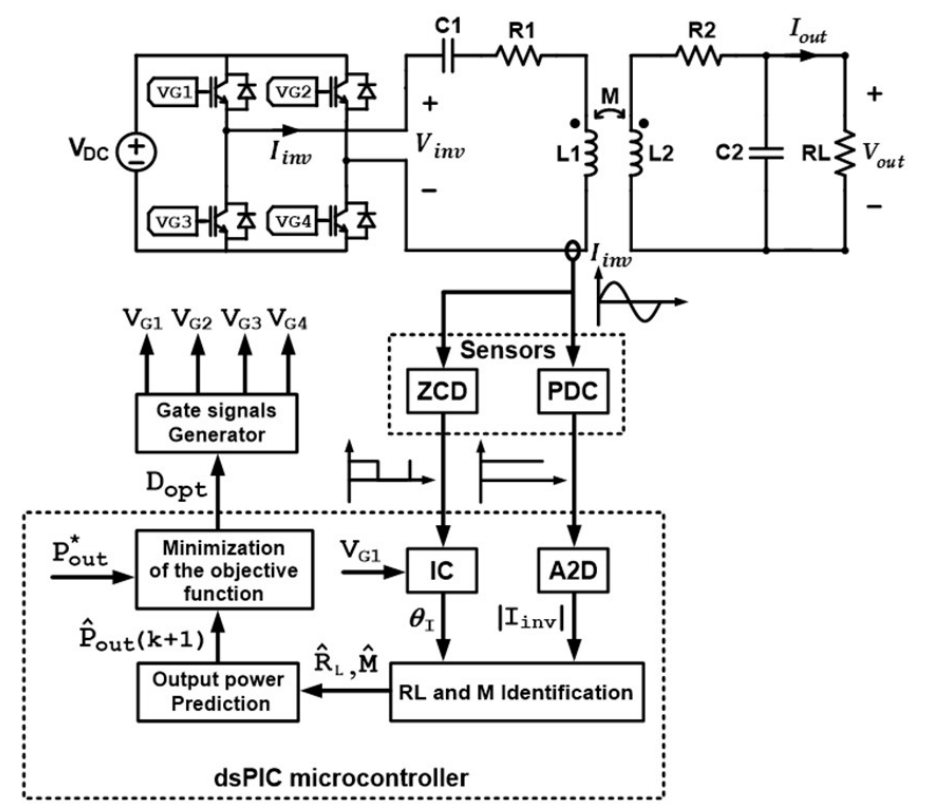
Figure 6. The proposed system.